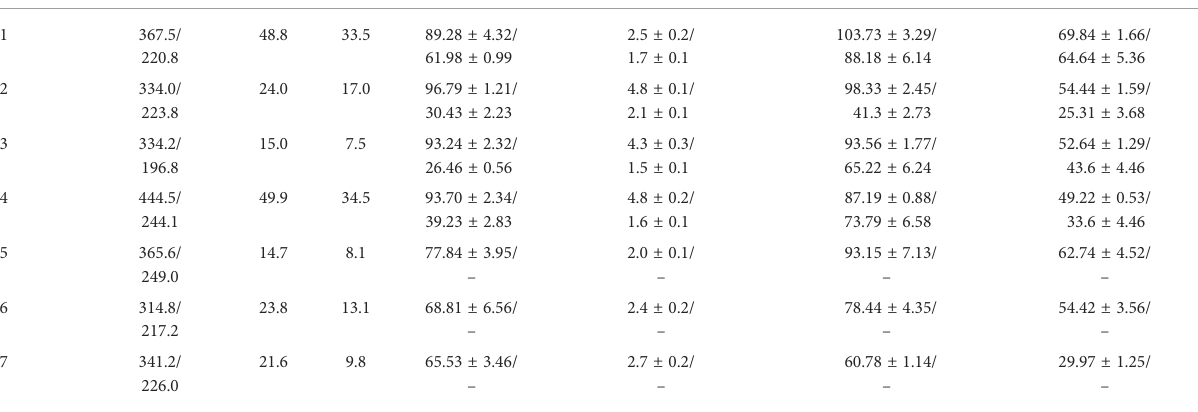
TABLE 2 Information about different sea cucumber individuals and their sperm before and after